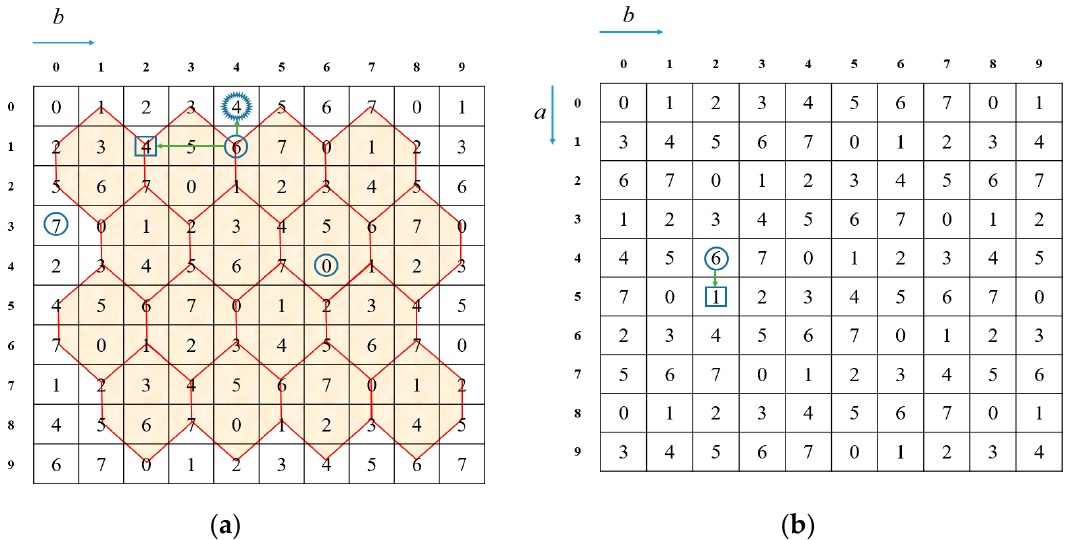
Figure 1. Embedment of TSE and PPM. ( a ) Partial reference table of TSE The TSE embedding method embeds a digit ranging from 0 to 2 3 − 1 = 7 into a